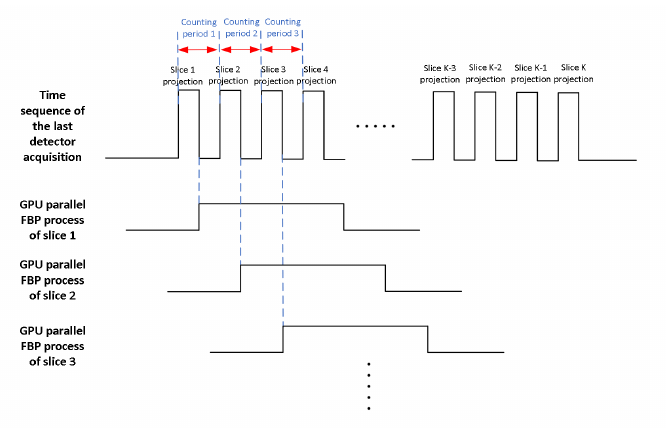
Figure 6. Time sequence of data